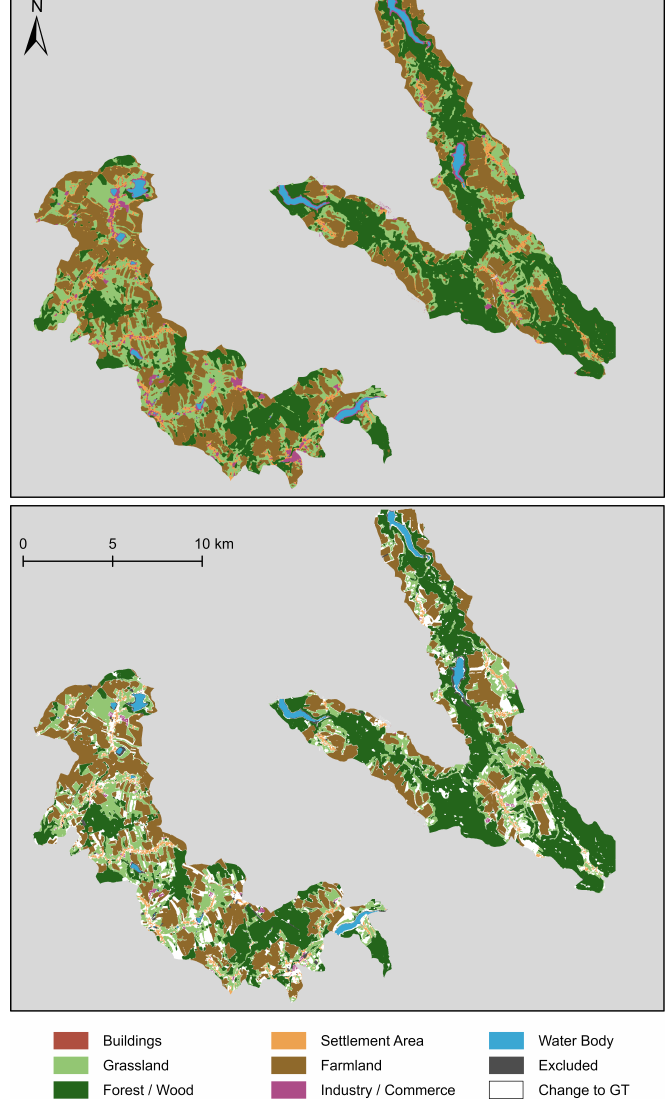
Figure 12. Visualization of the classification result of the LSTM F ( top ) and the differences between the GT and the LSTM F classification ( bottom ). The classification is the final classification of the 2018 data using six sequences of images and the introduced voting scheme. The differences are colored in